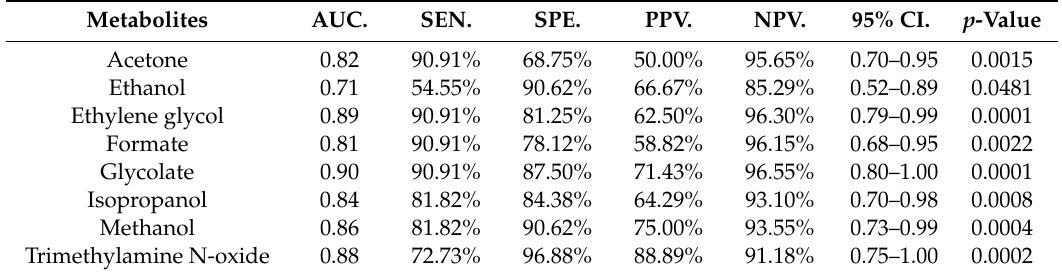
Table 2. Predictive performance of significant high metabolites in CVF.